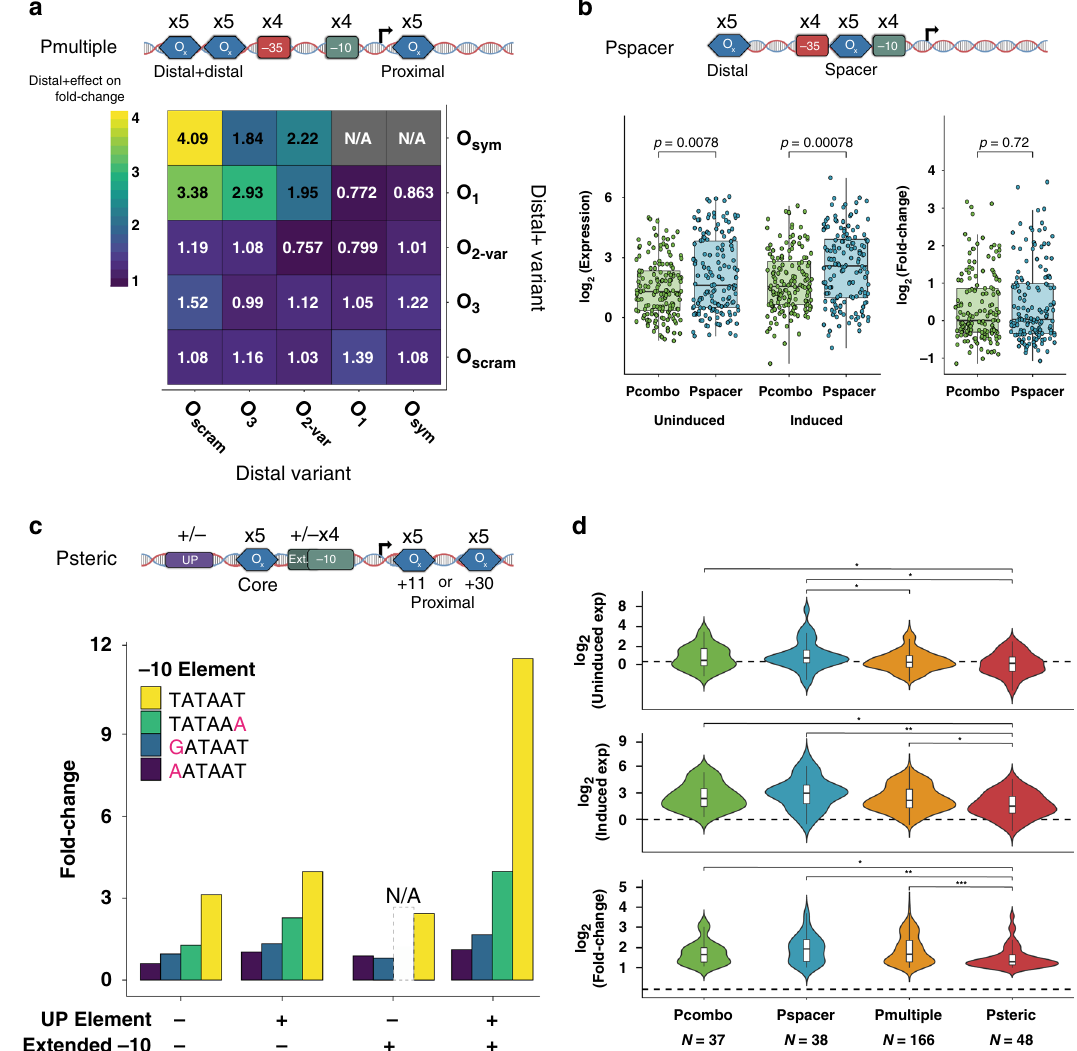
Fig. 4 Optimizing alternative IPTG-inducible promoter architectures. a Top: Design for Pmultiple library. Bottom: The average effect of the distal + site (rows) on fold change given the distal site identity (column). Here, we examine consensus − 10/ − 35 promoters containing O 1 or O sym in the proximal site. b Top: Design for Pspacer library. Bottom: Comparison of uninduced expression, induced expression, and fold change between variants composed of the same sequence elements in the Pspacer and Pcombo architectures (two-sided Mann – Whitney U tests, n = 305). We examined only active promoters containing a consensus − 10 and/or − 35 sequence. In each boxplot, the lower, middle, and upper hinges correspond to the fi rst quartile, median, and third quartile, respectively. Whiskers represent 1.5 × IQR from the lower and upper hinges. c Top: Design for Psteric library. Bottom: The fold change of promoters containing O 1 in both the core and proximal sites and a 56 bp interoperator distance. Here, we examine the effect of the − 10 element in conjunction with the strongest UP and extended − 10 element combinations. N/A indicates data missing from our analysis. d Distributions of uninduced expression, induced expression, and fold change for variants with fold change ≥ 2 in each library. The dashed line separates active from inactive sequences and is set as the median of the negative controls + 2*median absolute deviation (two-sided Mann – Whitney U tests with Benjamini – Hochberg correction, * P ≤ 0.05, ** P ≤ 0.01, *** P ≤ 0.001). The exact P values are: uninduced (Pspacer – Psteric: P = 0.029, Pspacer – Pmultiple: P = 0.040, Pcombo – Psteric: P = 0.045), induced (Pspacer – Psteric: P = 0.002, Pcombo – Psteric: P = 0.013, Pmultiple – Psteric: P = 0.013), fold change (Pmultiple – Psteric: P =